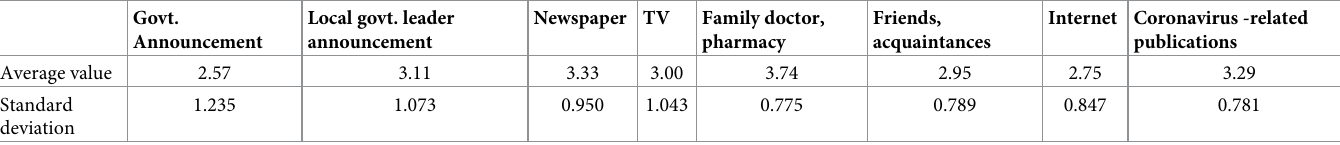
Table 9. Reliability of information. Govt.